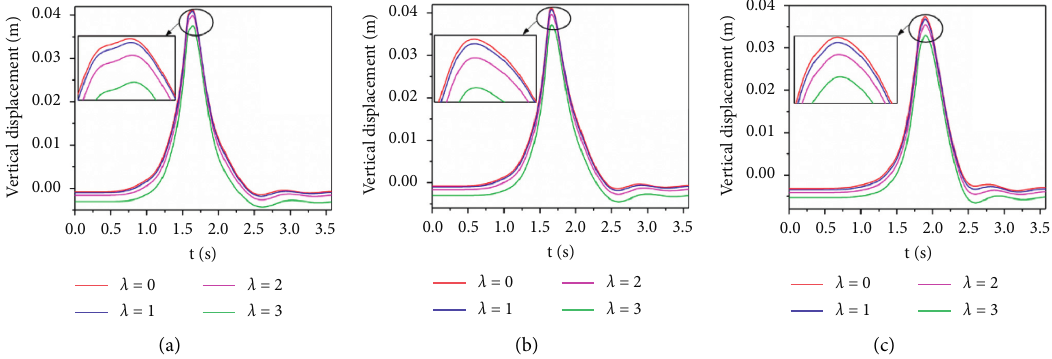
Figure 10: Characteristic curve of specific point (combinatorial material method). (a) Support positioning position. (b) The first dropper. (c) The mid-span.